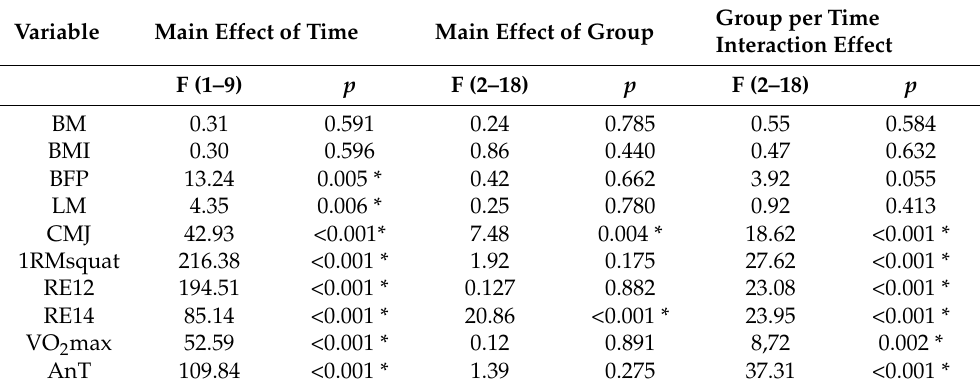
Table 3. Between-subjects comparisons of all the variables assessed: main effect of time, main effect of group, and interaction effect.